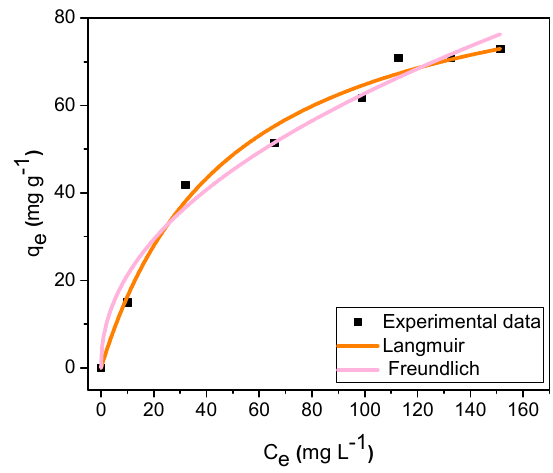
Figure 5. Adsorption isotherms for the removal of TC. Table 1. Comparison of the maximum adsorption (q_max) of different adsorbents for the removal of TC.